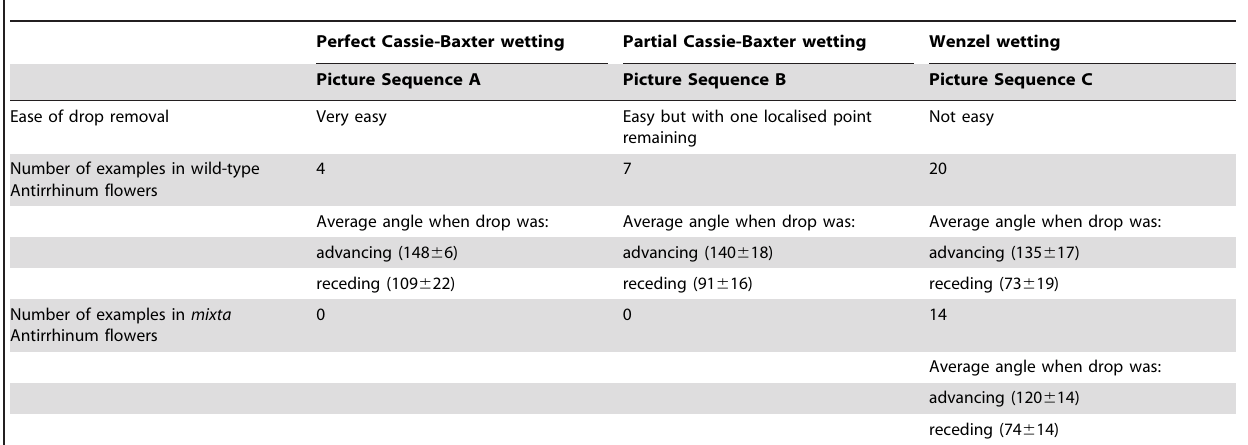
Picture sequences refer to Figure 3.